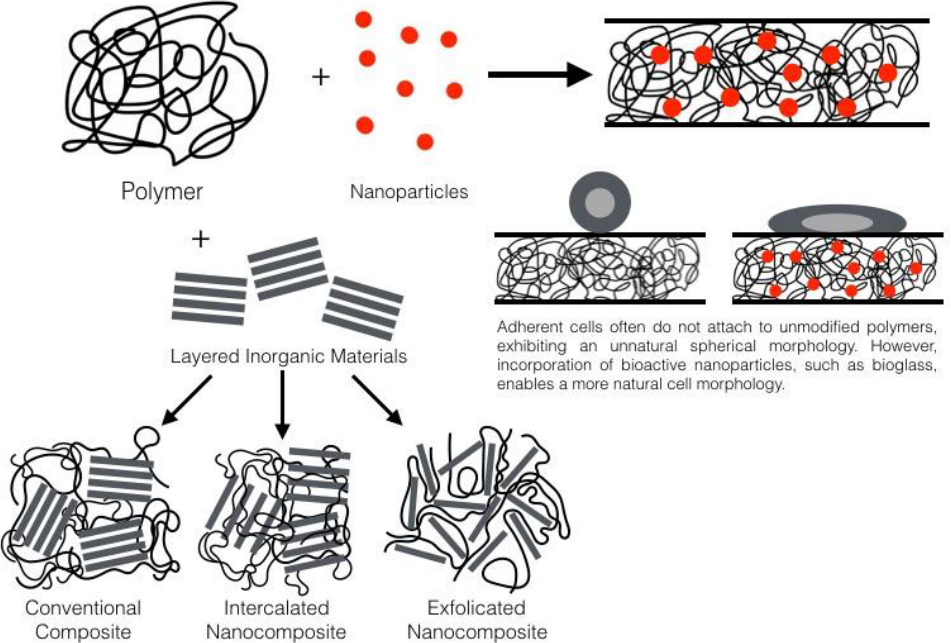
Figure 2. Two types of polymer-based nanocomposites.